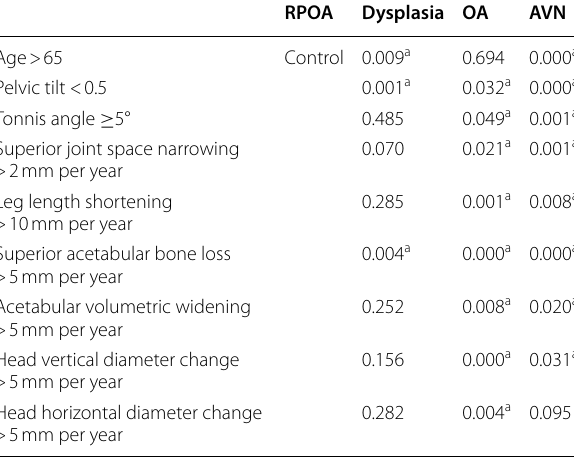
Table 4 The results validated using our proposed